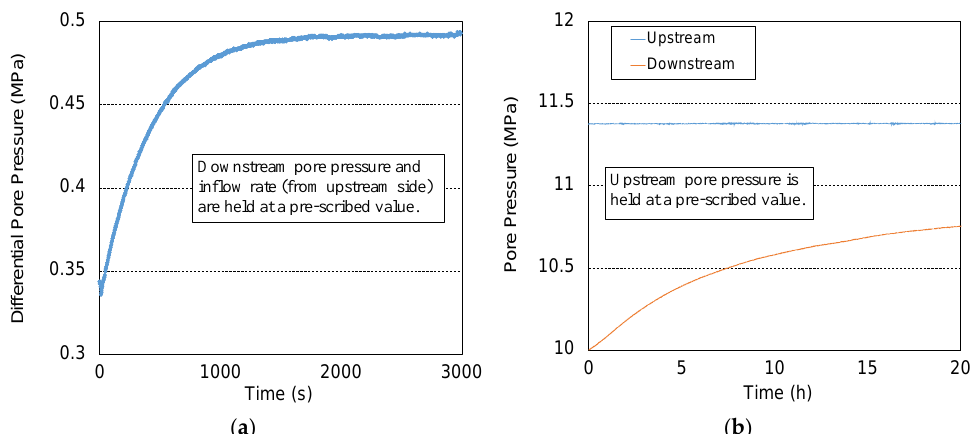
Figure 3. Evolution of ( a ) differential pore pressure in a steady-state measurement, and ( b ) downstream pore pressure in a modified pulse-decay measurement.